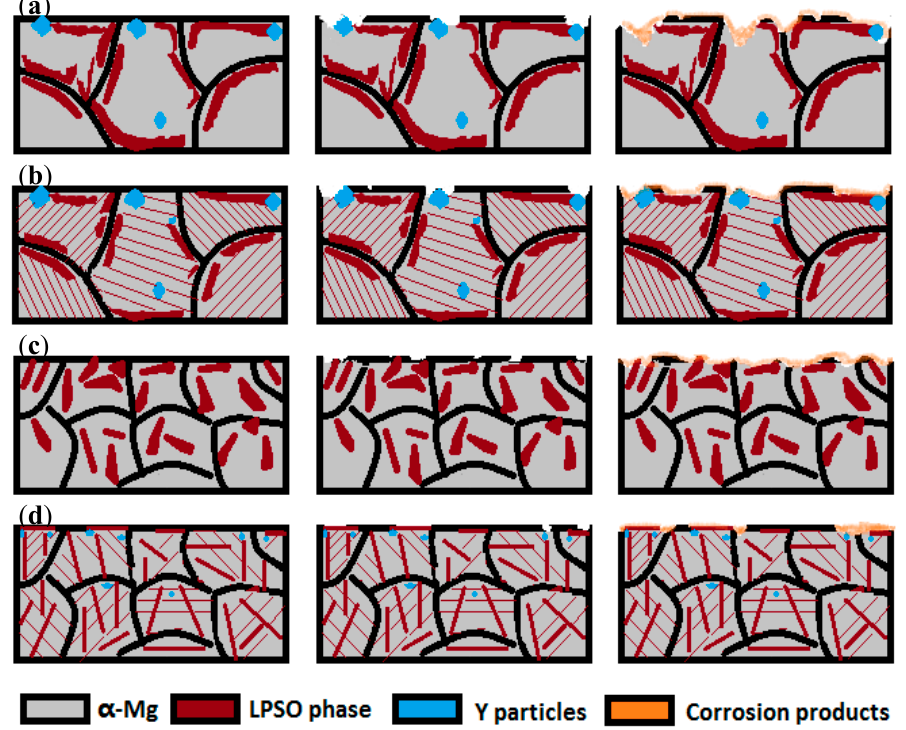
Figure 10. Schematic map during corrosion process for as-cast ( a ); pre-extrusion heat-treated ( b ); as-extruded ( c ); and post-extrusion heat-treated ( d ) Mg 95.33 Zn 2 Y 2.67